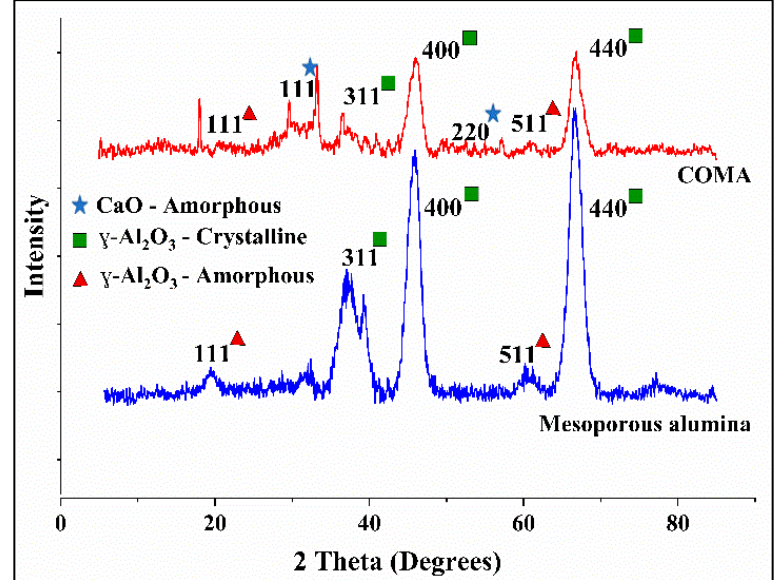
Figure 1. XRD patterns of mesoporous alumina and COMA.